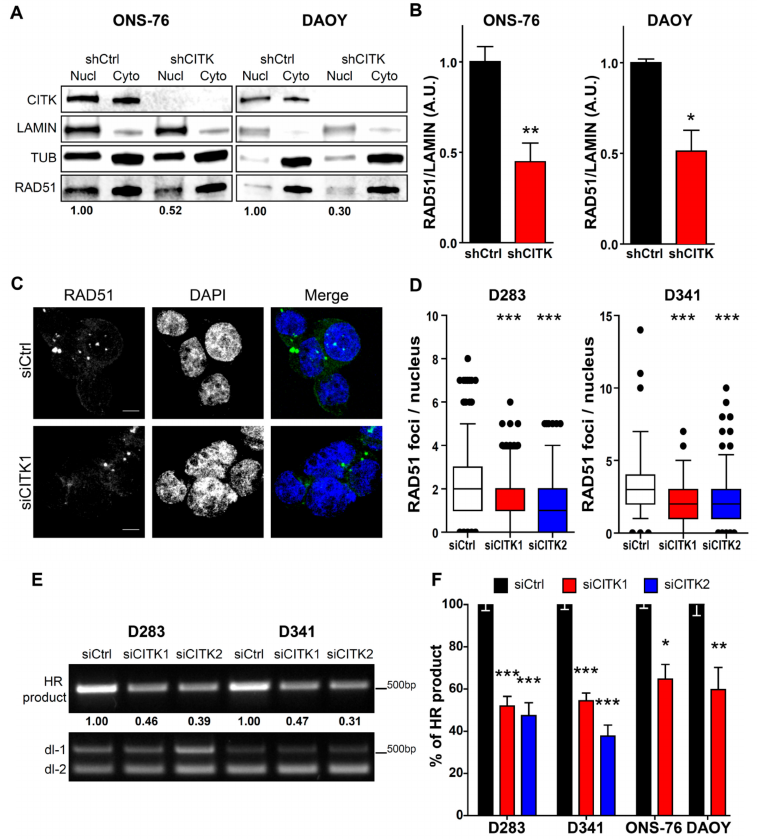
Figure 4. CITK knockdown reduces nuclear RAD51 and impairs homologous recombination. ( A ) Western blot analysis of nuclear (Nucl) and cytoplasmic (Cyto) fractions of ONS-76 and DAOY cells, expressing nontargeting sequence (shCtrl) or CITK-specific shRNA sequences under doxycycline-inducible control. Cells were analyzed 48 h after shRNAs induction with doxycycline-containing medium (2 µ mol / L). The levels of CITK and RAD51 were analyzed. The internal loading control was Lamin A (LAMIN) for the nucleus and Tubulin (TUB) for cytoplasm. ( B ) Quantification of the relative density of RAD51 in ONS-76 and DAOY nuclei, normalized on Lamin A and average shCtrl levels. ( C ) Representative images of D283 cells stained with DAPI and anti-RAD51 antibody 72 h after transfection with nontargeting or CITK-specific siRNA. ( D ) Quantification of RAD51 foci in nuclei of D283 and D341 cells treated with the indicated siRNAs. ( E ) Semiquantitative analysis of homologous recombination products generated in CITK-knockdown D283 and D341 cells, 100 and 72 h after transfection with the indicated siRNAs, along with recombinogenic dl-1 and dl-2 plasmids. A PCR for the total dl1 and dl2 sequences was performed as internal control of transfection e ffi ciency. ( F ) Quantification of the homologous recombination product formation in D283, D341, ONS-76 and DAOY treated cells, normalized on the internal controls. All quantifications were based on at least three independent biological replicates. Error bars, SEM. *, p < 0.05; **, p < 0.01, ***, p < 0.001; two-tailed Student’s t -test. ***, p < 0.001 Mann–Whitney U test for RAD51 foci. Scale bars, 5 µ